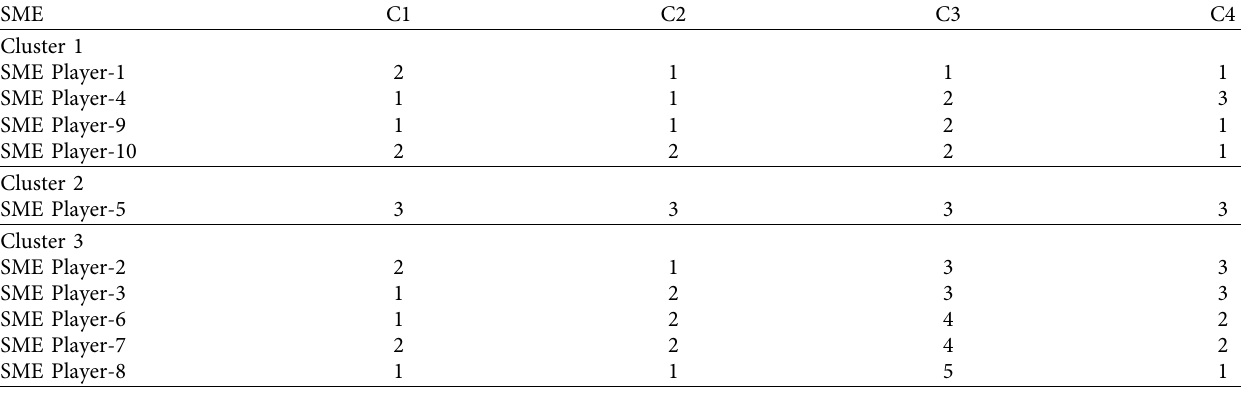
Table 21: Cluster group result of SME segmentation.